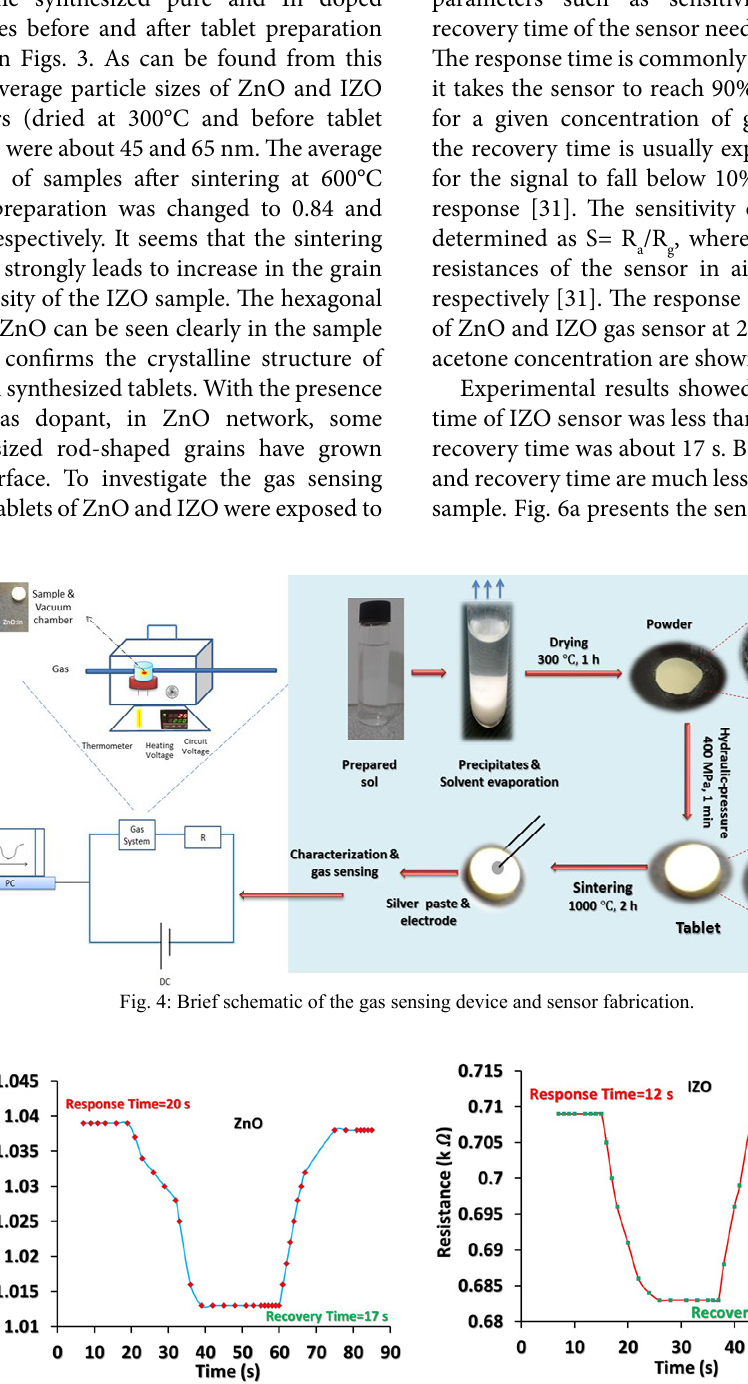
Fig. 5: Response and recovery curves of the samples for 1500 ppm acetone at Fig. 5